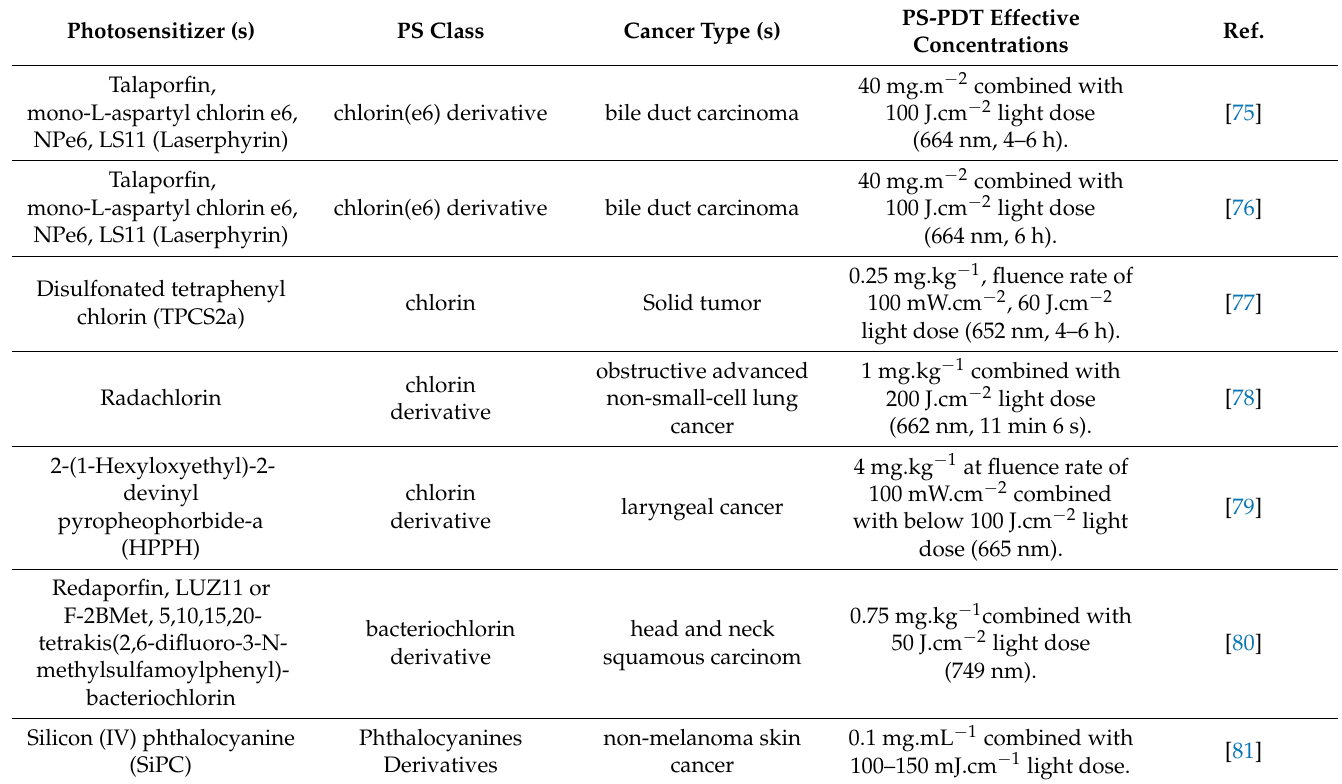
Table 2. Photosensitizers in ongoing and/or approved clinical trials for PDT for